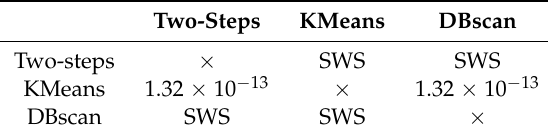
Table 22. p -values for instance f.6.